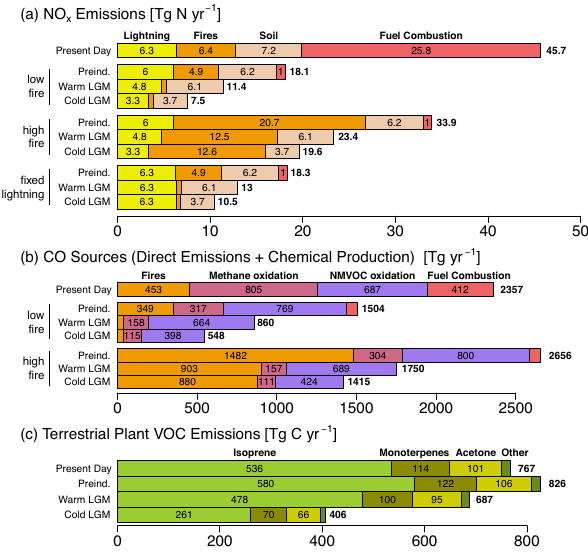
Fig. 5. Gas phase emissions used for each climate scenario. We test two different fire emission scenarios, a high fire scenario with past Fig. 5. Gas-phase emissions used for each climate scenario. We test fire emissions from the LPJ-LMfire model (Pfeiffer et al., 2013), and a low fire scenario in which we scale the model output by sediment recordsofcharcoalaccumulationrates(Poweretal.,2008).Wealsoperforma fixedlightning suiteofsimulationsinwhichwescalethetotal two different fire emission scenarios, a high-fire scenario with past lightning NO x sourcetobeconstantindifferentclimates. fire emissions from the LPJ-LMfire model (Pfeiffer et al., 2013), and a low-fire scenario in which we scale the model output by sed- iment records of charcoal accumulation rates (Power et al., 2008). We also perform a fixed lightning suite of simulations in which we scale the total lightning NO x source to be constant in different cli- mates.